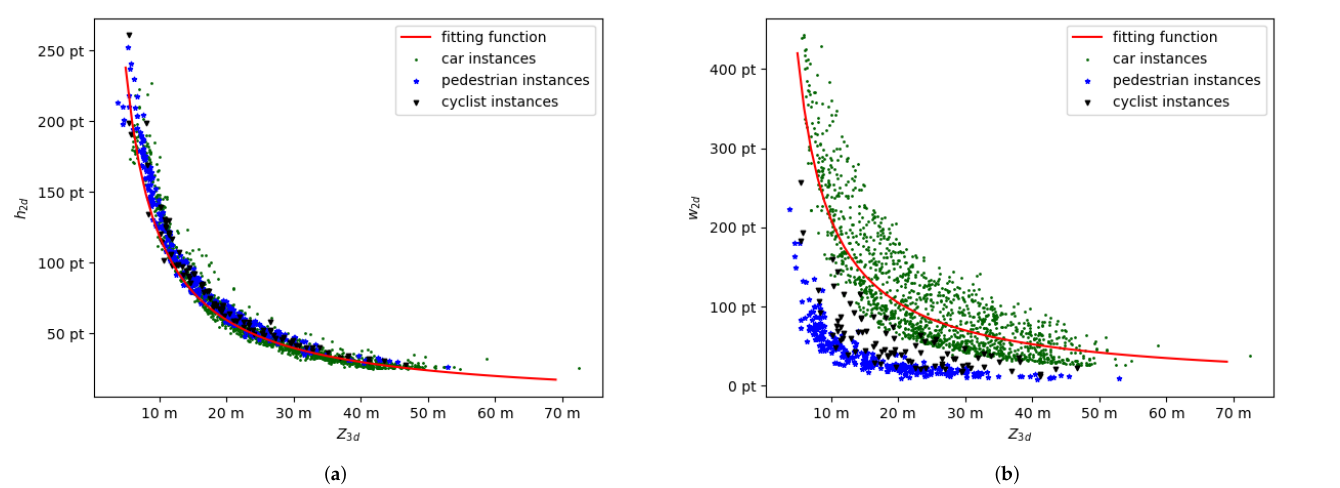
Figure 3. ( a ) The correlation of Z 3 d and h 2 d for part ground-truth boxes in the KITTI dataset and the fitting curve (red curve). ( b ) The correlation of Z 3 d and w 2 d for part ground-truth boxes in the KITTI dataset and the fitting curve (red curve). We use green points, blue stars, and black triangles to denote cars, pedestrians, and cyclists,